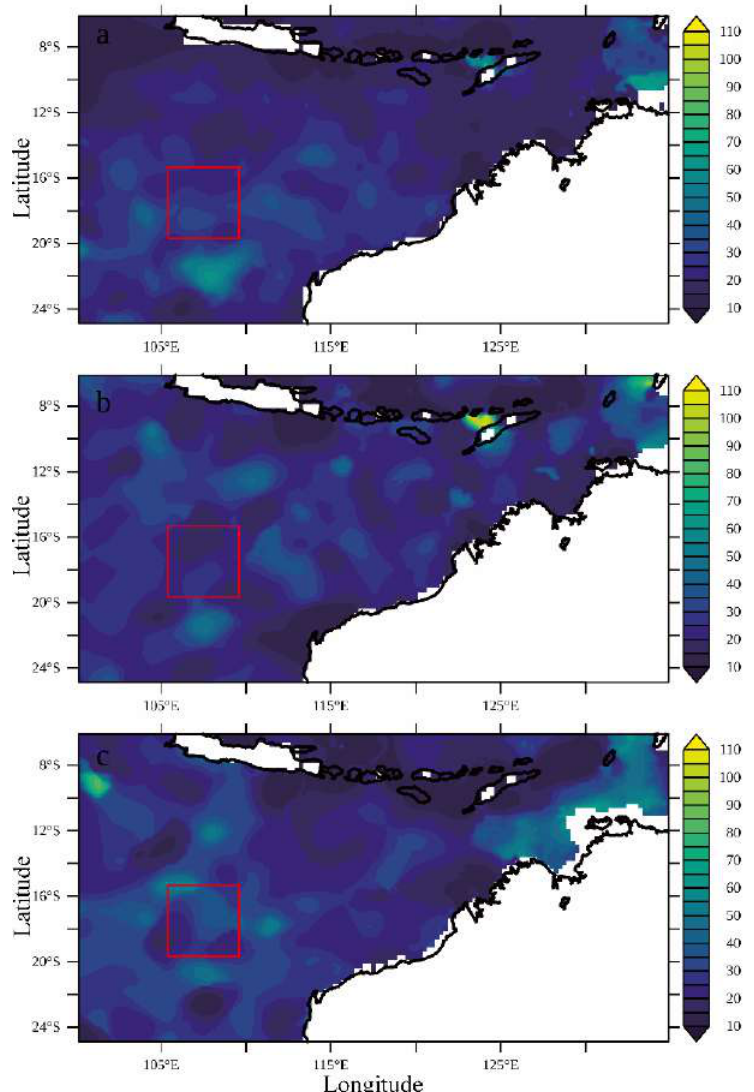
Fig. 5: Distribution of weekly MLD (color in m): (a) before Cyclone Marcus (11-17 March 2018), (b) during Cyclone Marcus (18-25 March 2018), (c) after Cyclone Marcus (26-31 March 2018)